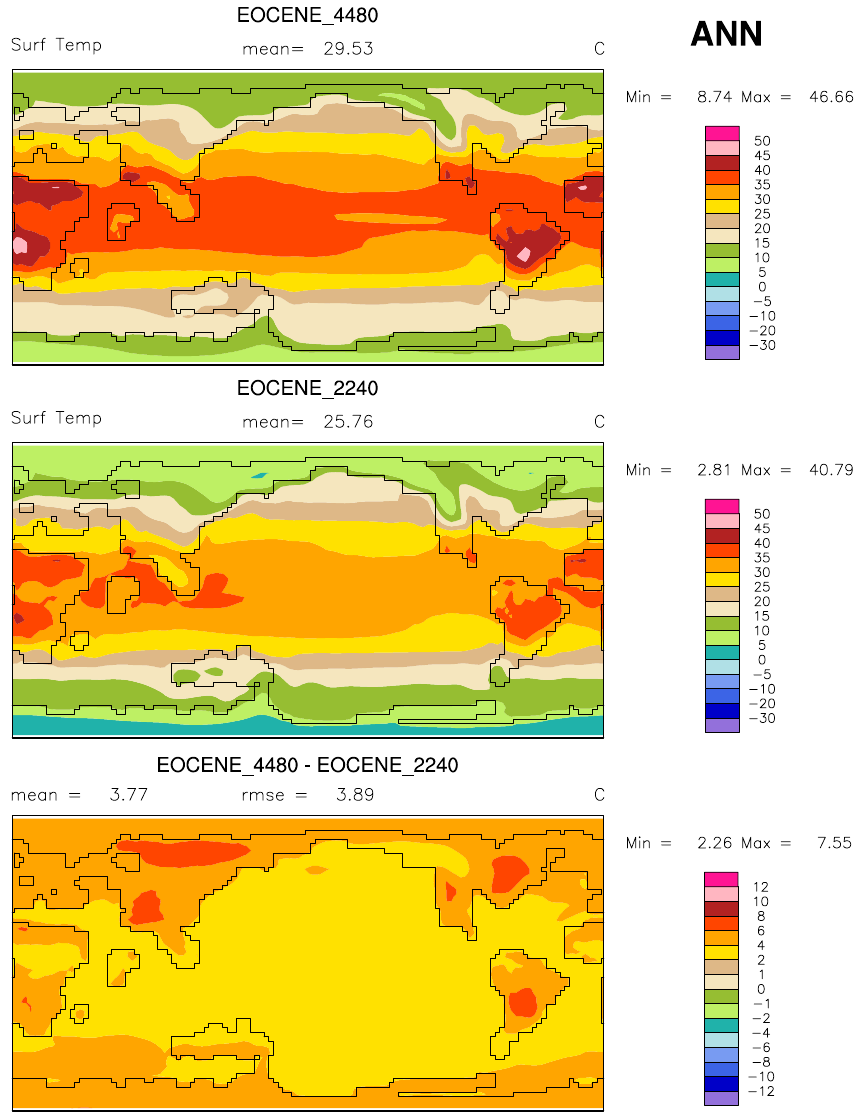
Fig. 3a. Maps of time averaged surface temperature from the EOCENE-4480 and EOCENE-2240 simulations. The annual (a) , boreal winter (b) , and boreal summer (c) means are shown. The upper row is the EOCENE-4480 case, the middle row is the EOCENE-2240 case, and the bottom row is the anomaly. The range is values is indicated in the color bar in (a) and is the same in (a–c) . Units are in ◦ C